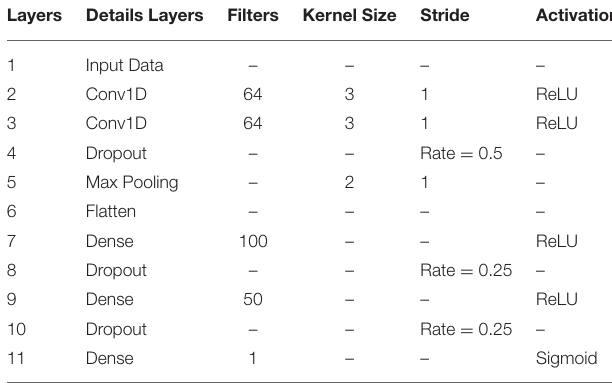
TABLE 3 | The details of the third proposed 1D-CNN